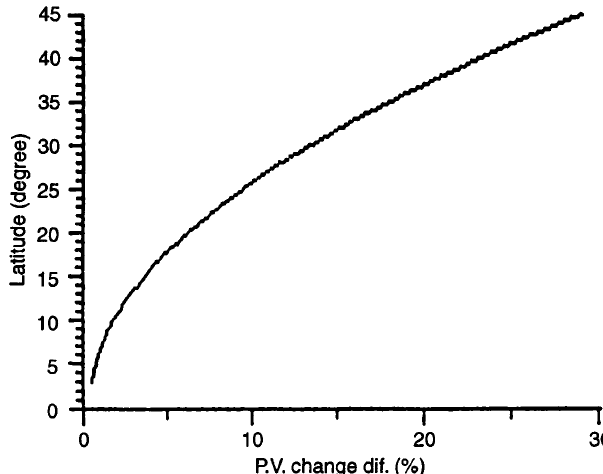
Fig. 10. Di(cid:128)erence between the planetary vorticity change on the equatorial b -plane and on the spherical coordinates (in %) as a function of the